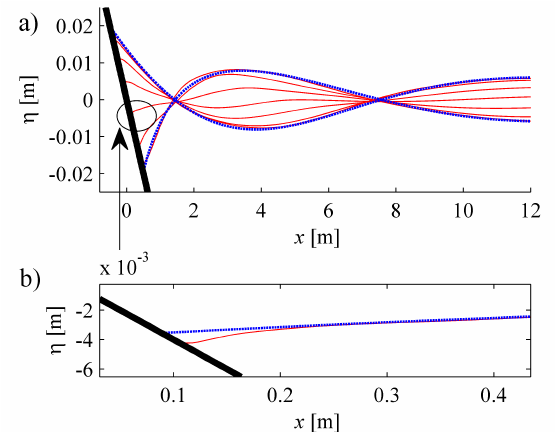
Figure 4. ( a ) Envelope of free surface of sine wave run-up on a planar beach. Comparison between the weakly dispersive model (blue dotted lines) and Carrier and Greenspan [28] analytical solution (continuous red lines). ( b ) A zoom of the surface elevation near the planar beach at an intermediate time step.